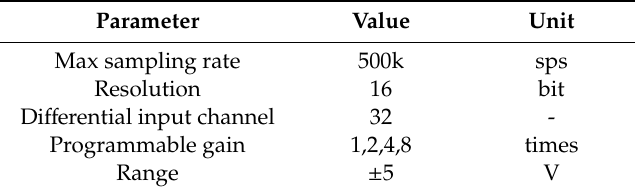
Table 6. The parameters of the data acquisition card